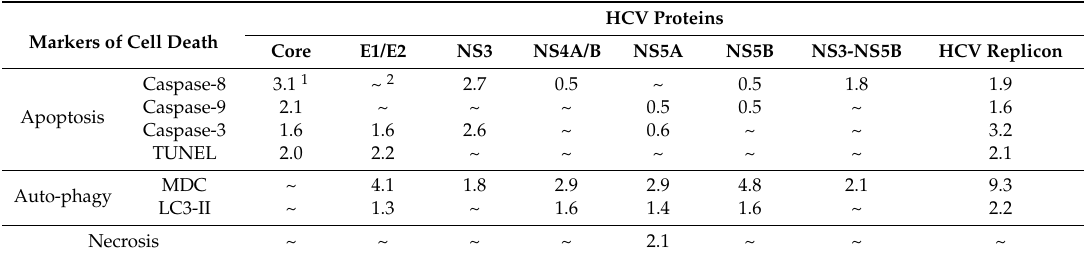
Table 1. Impact of HCV proteins on promoting various types of death of Huh7.5 hepatoma cells. HCV Proteins Markers of Cell Death Core E1/E2 NS3 NS4A/B HCV